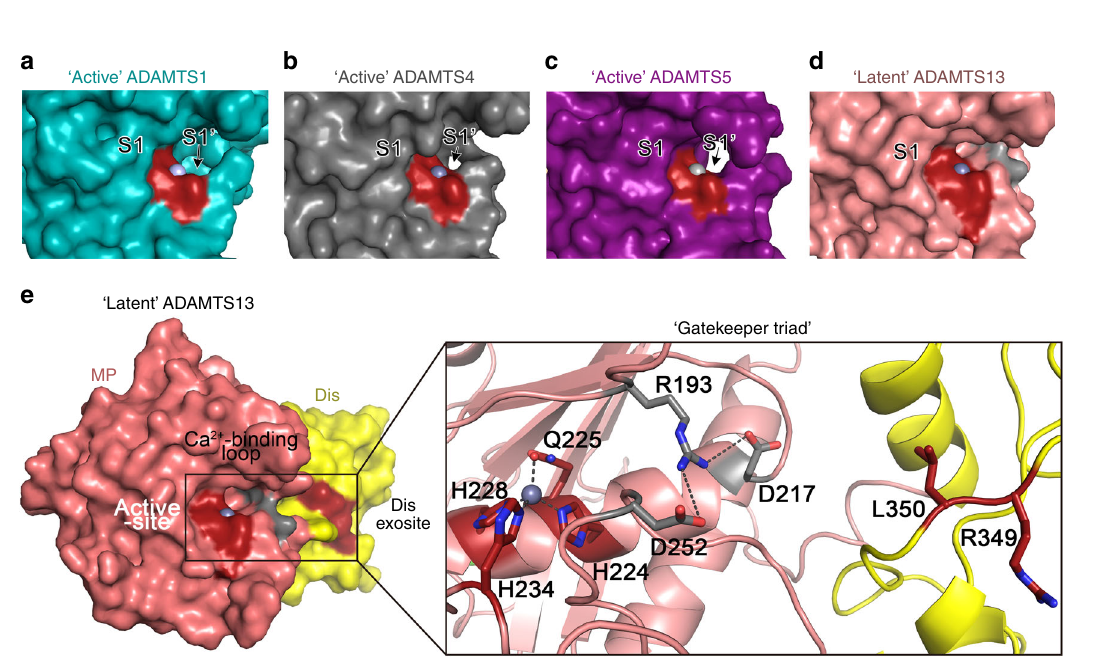
Fig. 8 The ADAMTS13 metalloprotease (MP) domain exhibits a “ closed ” conformation and a “ gatekeeper triad. ” a – c Structures of the active-sites of ADAMTS1, 4, and 5 resolved in the presence of active-site inhibitors (not shown) revealing the conformation of the “ active ” protease when the active-site accommodates a substrate PDB ID: 3Q2G [https://doi.org/10.2210/pdb3Q2G/pdb], 4WK7 [https://doi.org/10.2210/pdb4WK7/pdb], and 3LJT [https://doi.org/10.2210/pdb3LJT/pdb], respectively. Active-site His residues are shown in red with bound Zn 2 + ion shown as a gray sphere — all structures are shown in the same orientation. In the standard orientation for MP domain substrate engagement, the scissile bond lies over the active-site. The R-group of the P1 residue is accommodated by the S1 pocket (highlighted). The S1 ′ pocket is recessed into the MP domain to accommodate the P1 ′ residue R-group (arrows). d In ADAMTS13, the S1 ′ pocket is occluded due to ionic interactions of the “ gatekeeper triad ” (gray) residues giving a “ latent